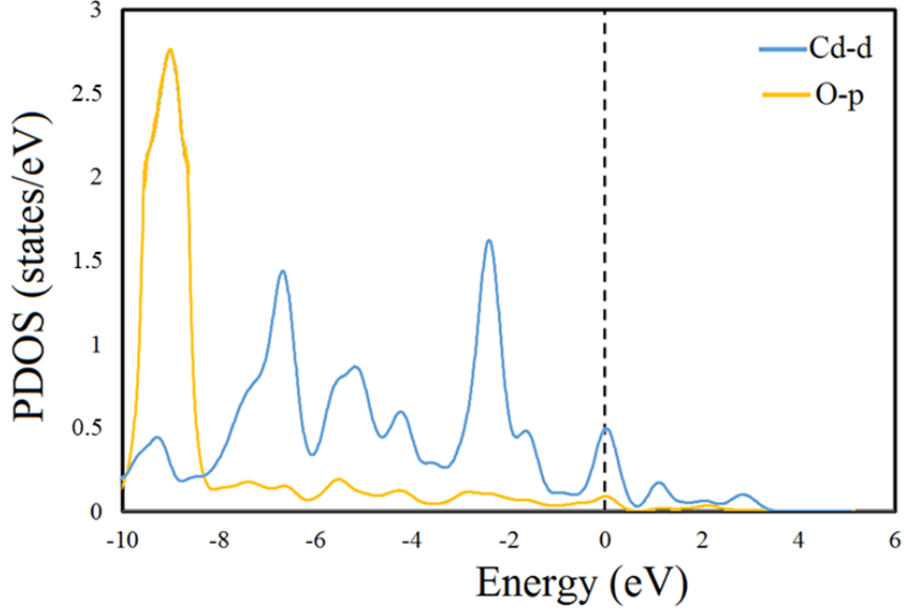
Figure 13. Graphical representation of partial density of state (PDOS) of optimized geometry of AC